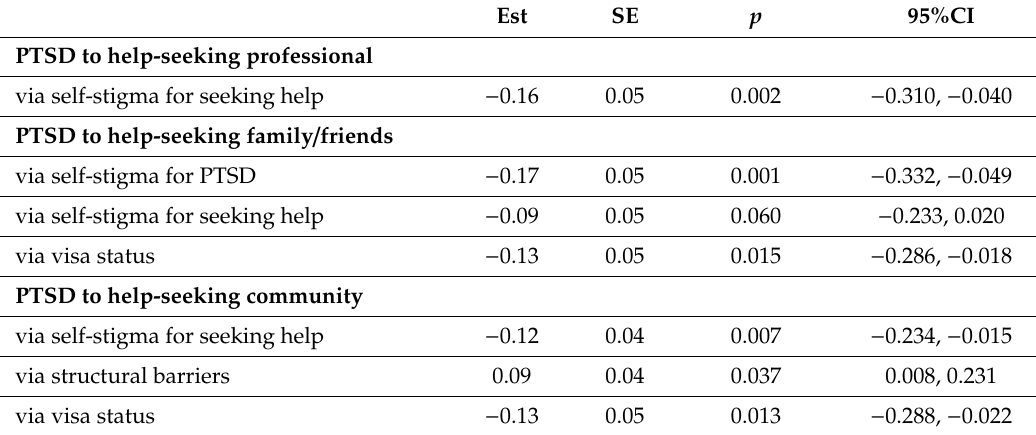
Table 3. Summary of indirect e ff